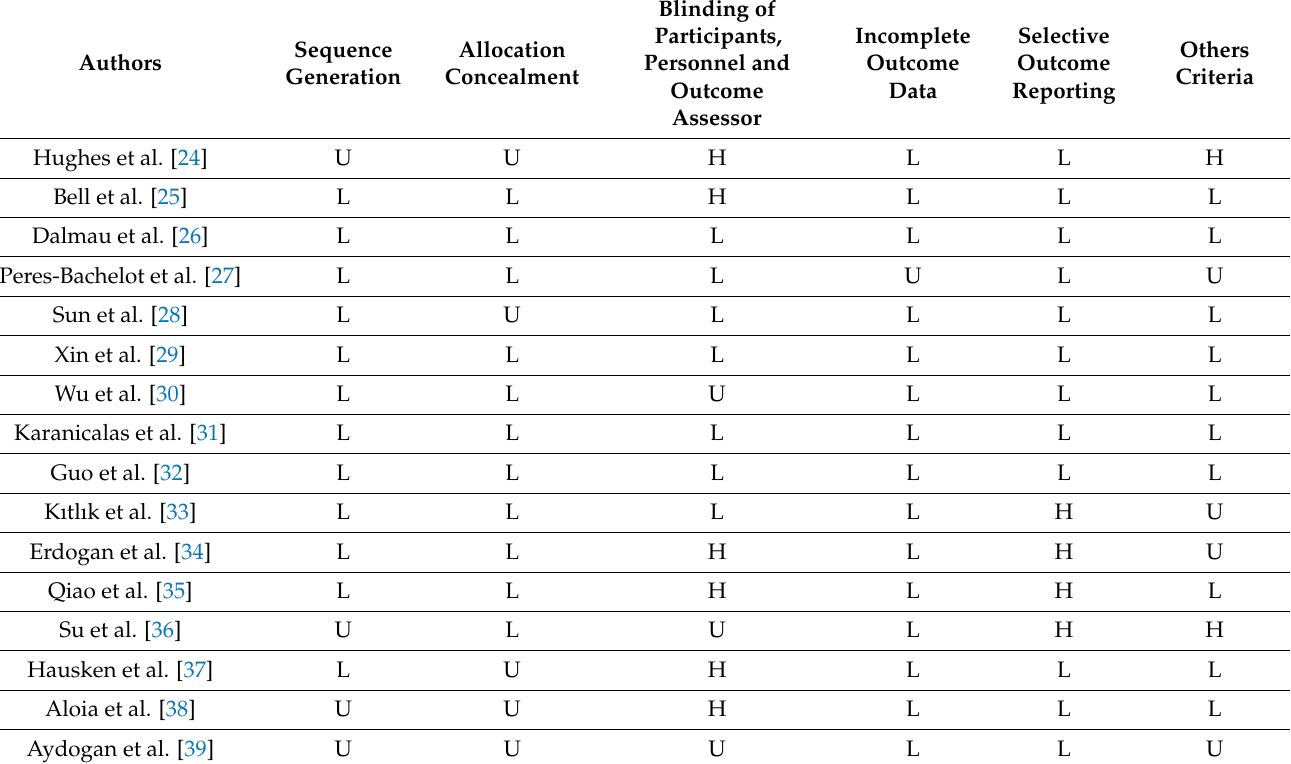
Table 1. Risk of bias for the randomized controlled trials